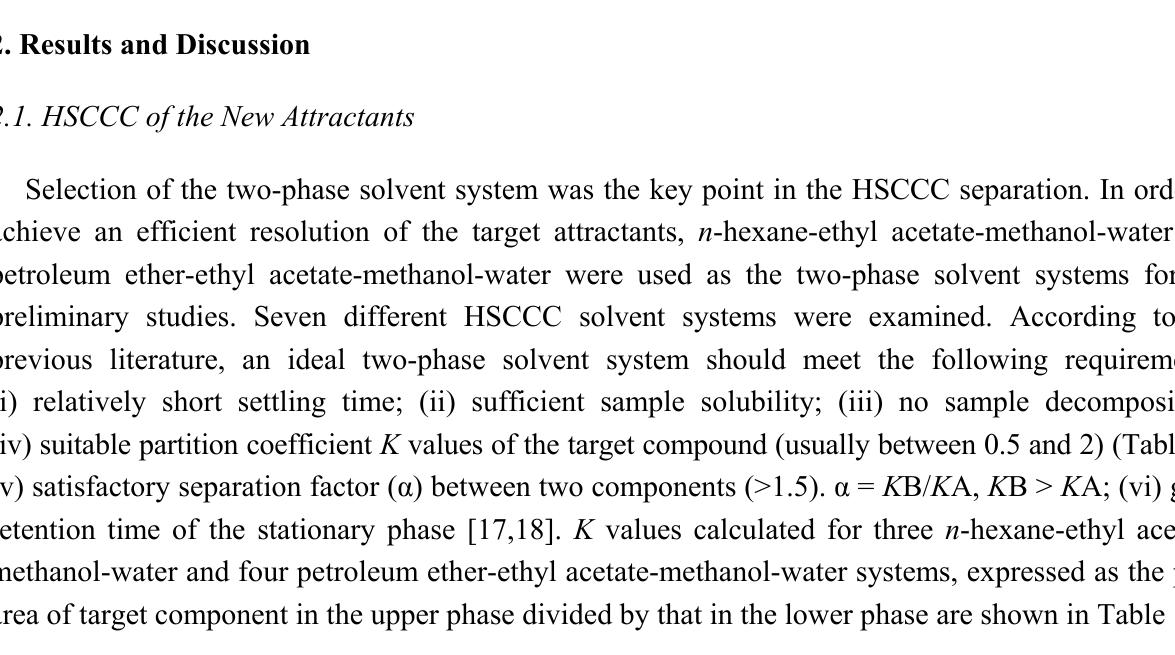
Table 1. The K -values and separation factors of the target compounds in several solvent